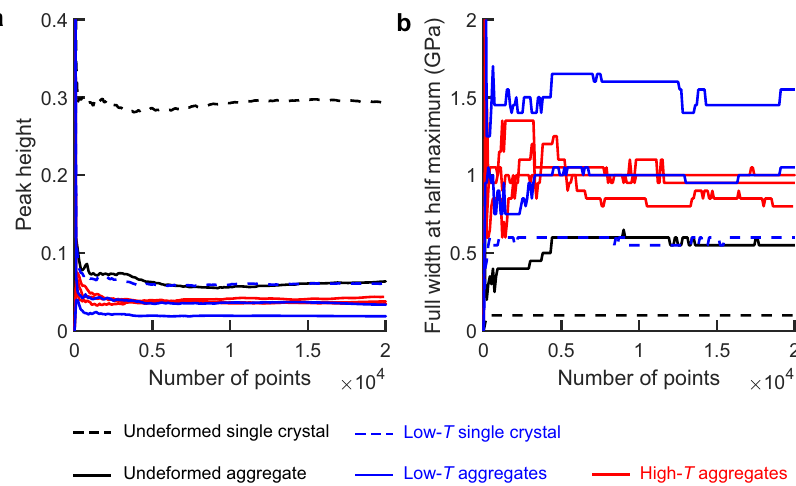
Fig. 3 Dependence of stress distributions on the size of the dataset. a Peak heights and b full widths at half maximum of the probability distributions of normalised σ 12 as functions of the number of points in the